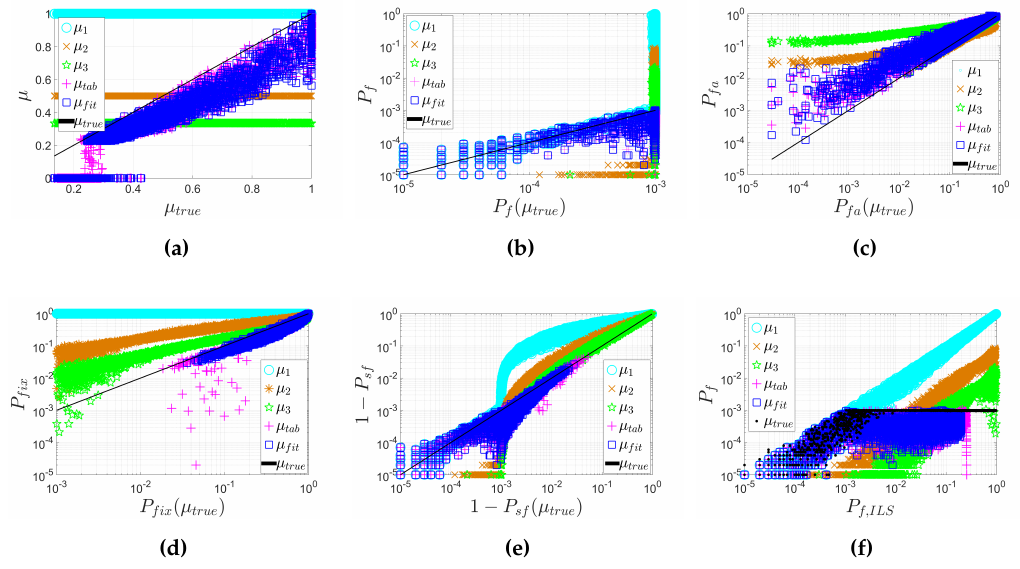
Figure 6. The comparison of critical value µ , failure rate P f , false alarm rate P fa , fix rate P fix and conditional failure rate ( 1 − P sf ) from different methods, with P tol µ true ; ( b ) P f vs. P f ( µ true ) ; ( c ) P fa vs. P fa ( µ true ) ; ( d ) P fix vs. P fix ( µ true ) ; ( e ) ( 1 − P sf ) vs. [ 1 − P sf ( µ true )] ; ( f ) P f vs. P f , ILS .